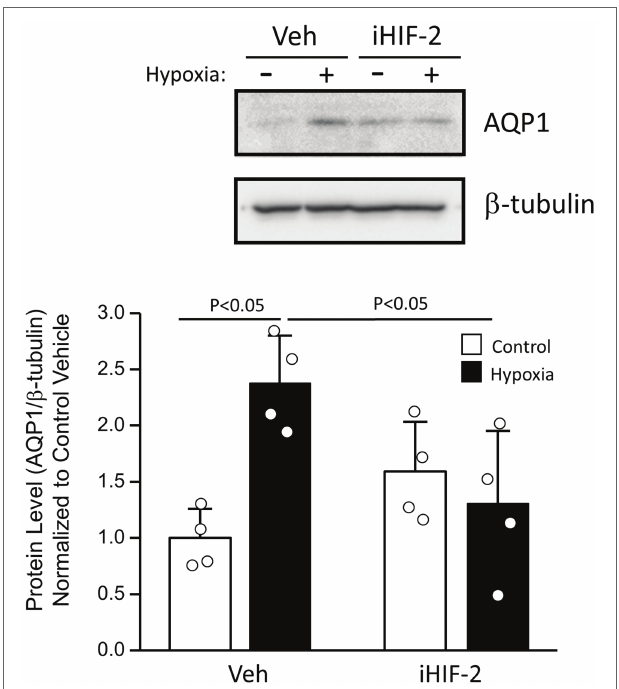
FIGURE 2 | Effect of exposure to in vitro hypoxia on aquaporin 1 (AQP1) protein levels in MVECs. Representative immunoblot showing AQP1 and β -tubulin protein expression in MVECs exposed to 4% O 2 for 48 h. Cells were treated with vehicle (Veh; 1:1,000 DMSO) or TC-S 7009 (10 μ M), a hypoxia- inducible factor-2 (HIF-2) inhibitor (iHIF-2) prior to hypoxic challenge. Bar graphs show mean ± SD values for the ratio of AQP1 to β -tubulin protein levels, normalized to Control + Veh group. Value of p determined from two- way ANOVA with Holm-Sidak post-test. Each dot represents samples from different animals.